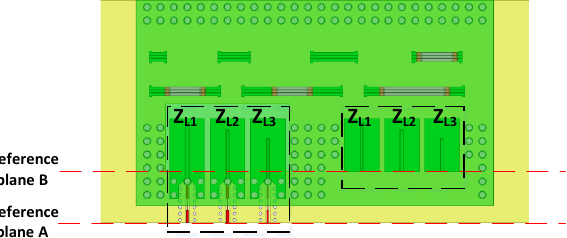
Figure 7. Top view of the simulation model for the single port test.